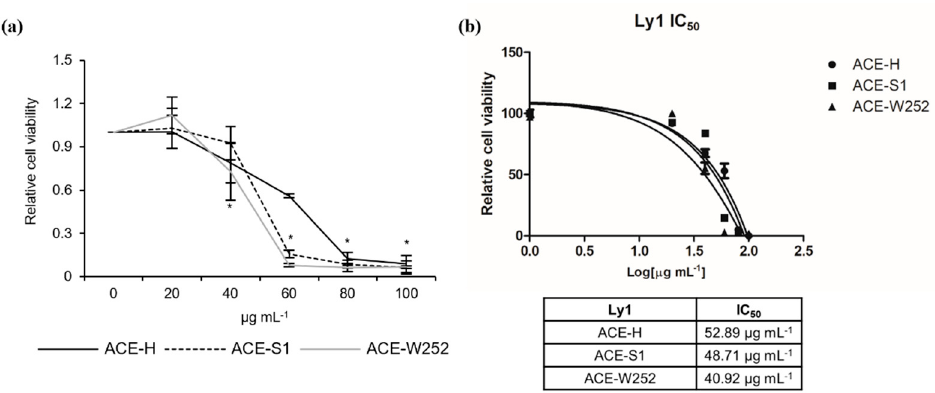
Figure 1. ACE-H, ACE-S1, and ACE-W252 reduces cell viability in Ly1 human B lymphoma cells. ( a ) Ly1 cells were treated with ACE-H, ACE-S1, or ACE-W252 (0, 20, 40, 60, 80, and 100 μ g mL − 1 ) for 24 h, and cell viability was measured using an MTS assay. ( b ) The IC50 values of ACE-H, ACE-S1, and ACE-W252 in Ly1 cells were calculated using GraphPad Prism 5 software (GraphPad Software, Inc., San Diego, CA, USA). Statistical significance was calculated using the two-tailed Mann–Whitney test (* p < 0.05).